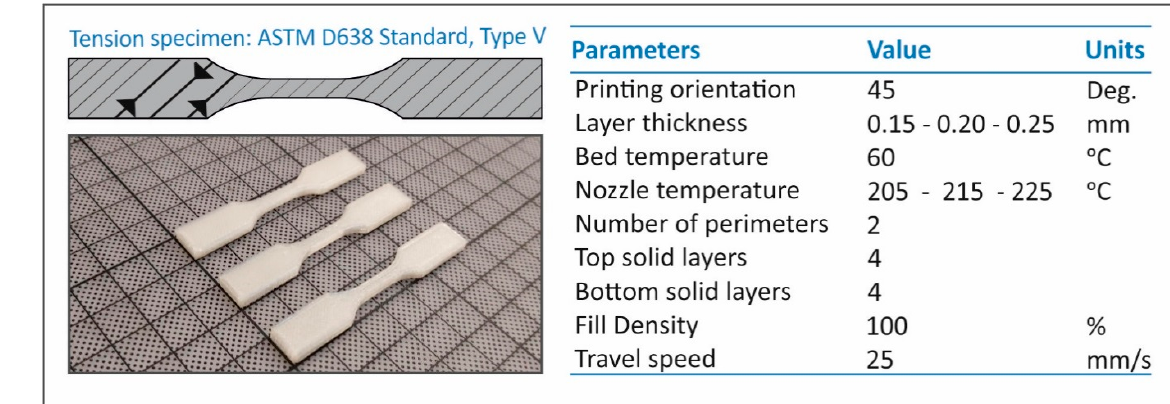
Figure 2. Fused filament fabrication process main parameters set for the manufacturing of the specimens with the tested